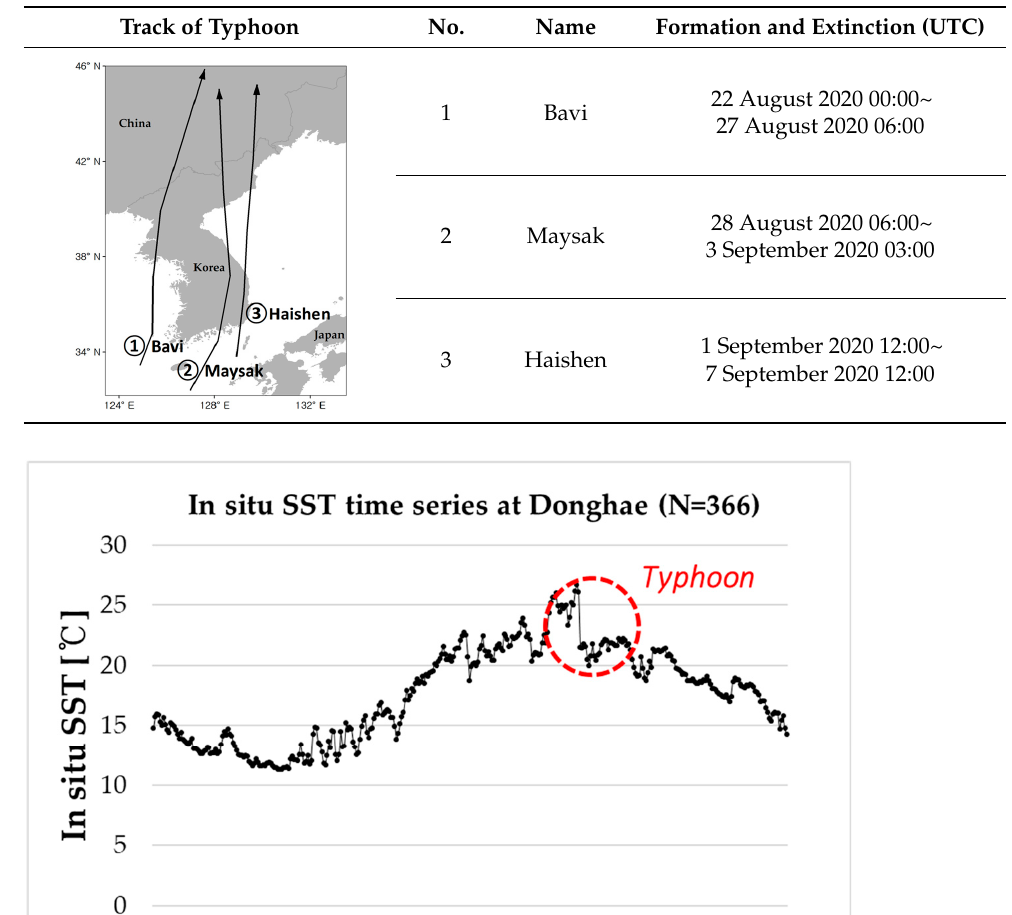
Figure 18. The in situ SST measurements at Donghae in 2020. A sharp decrease from 26.13 °C to 21.52 °C occurred due to typhoons.